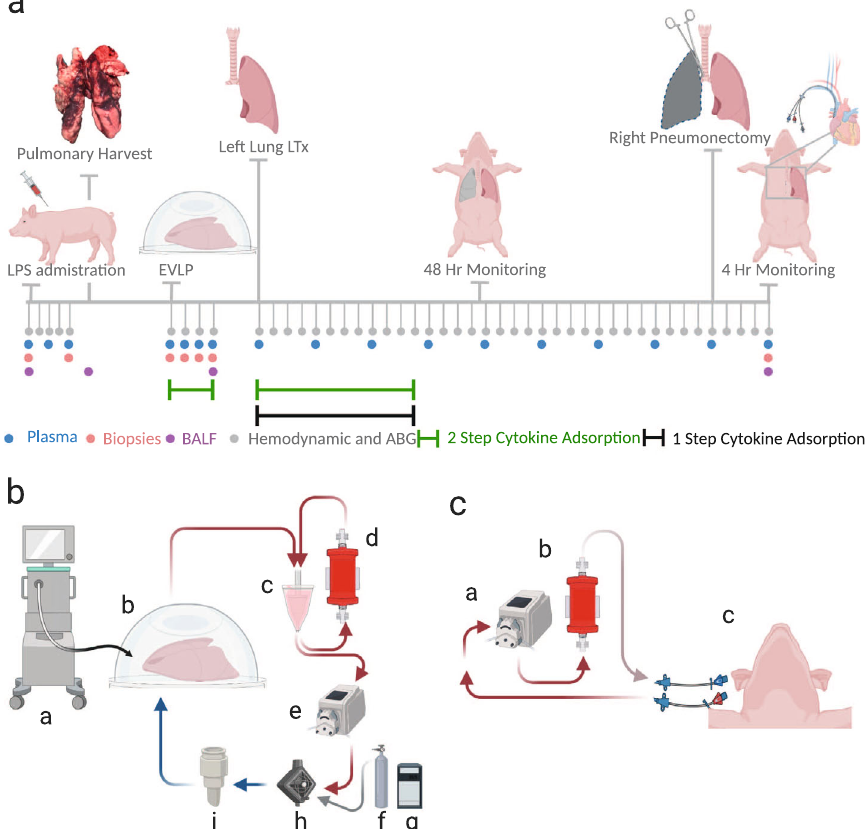
Fig. 1 Experimental overview and technique for cytokine adsorption and lung transplantation. a Timeline of lipopolysaccharide (LPS)-induced acute respiratory distress syndrome (ARDS) lung injury and lung recovery by therapeutic interventions during ex vivo lung perfusion (EVLP) and transplantation (LTx) follow-up. Sample collection, including, plasma, biopsies, bronchoalveolar lavage fl uid (BALF), hemodynamic measurements and arterial blood gases (AGB) and differential treatment regimens are indicated. Pulmonary harvest was conducted after con fi rmation of ARDS and the lungs where then placed on EVLP. The recipient was monitored for 48 hours after left lung transplantation and a mid-sternotomy followed by a right pneumonectomy in the last four hours allowed for isolated monitoring of the transplanted lung. A Swan-Ganz catheter was also placed in this monitoring period. b Setup of cytokine adsorption during EVLP. A mechanical ventilator ( a ) was connected to the lungs in the dome (b). Flow of perfusate continued into the reservoir (c) which fed into the cytokine adsorber (d) that then directed adsorbed perfusate back into the reservoir. Flow continued as per established methodology using a peristaltic pump (e) into a deoxygenator (h) connected to a gas supply (f) and heater (g). Following the leukocyte fi lter (i), the perfusate returned to the lungs. c Setup of cytokine adsorption post-transplantation. A veno-venous shunt using a hemodialysis catheter was inserted into the jugular vein. This facilitated fl ow through a pump (a) that was in line with the cytokine adsorber (b). After adsorption, fl ow returned to the circulation via the hemodialysis catheter in the jugular vein. Created with